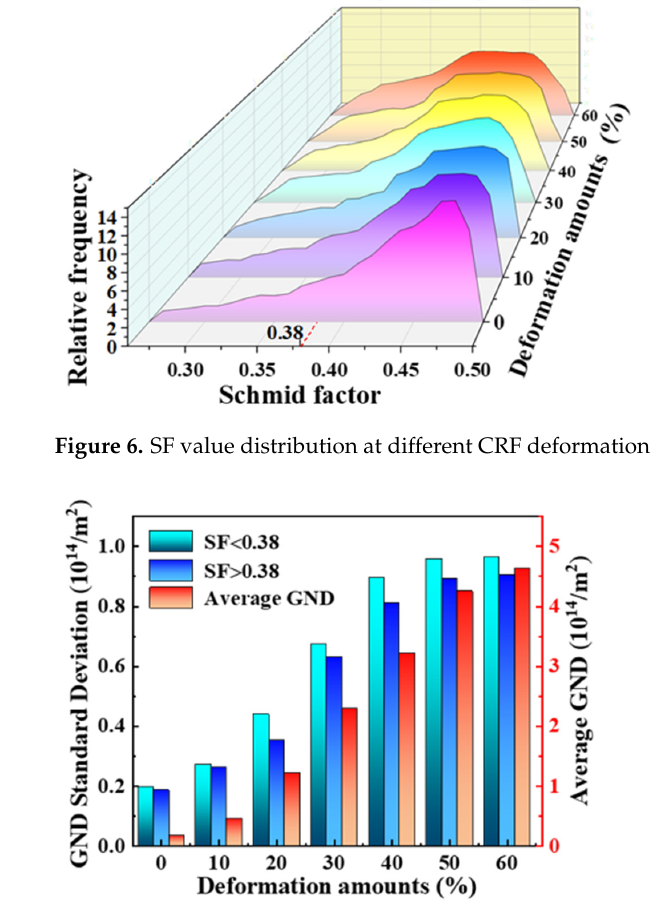
Figure 7. Average GND and GND standard deviation at different CRF deformation amounts.